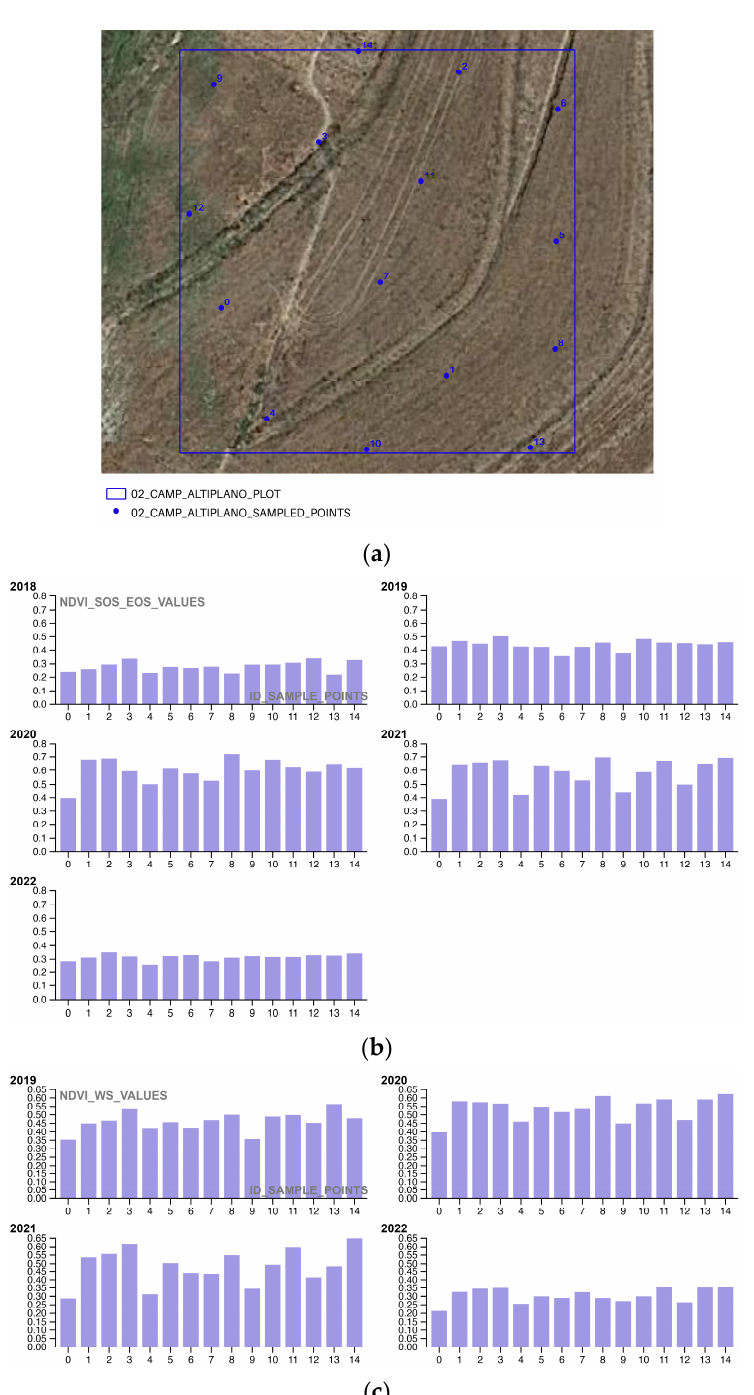
Figure 17. ( a ) The shapefile 02_CAMP_ALTIPLANO_PLOT.shp samples the COPERNICUS/S2_SR NDVI values of an exemplificative portion of the landscape restoration actions, in the specificity of the Camp Altiplano forest garden extent, encompassing a portion of the riparian vegetation; ( b ) the COPERNICUS/S2_SR NDVI vegetation trends SOS ‐ EOS phenological growth rate of the sample points (2018–2022) shows the trend in vegetation growth during the start of the growing season (SOS) and the end of the growing season (EOS) for the sampled Camp Altiplano plot; ( c ) the COPERNICUS/S2_SR NDVI vegetation trends WS phenological growth rate of the sample points (2018–2022) shows the trend in vegetation growth during the winter season (WS) for the sampled Camp Altiplano plot.